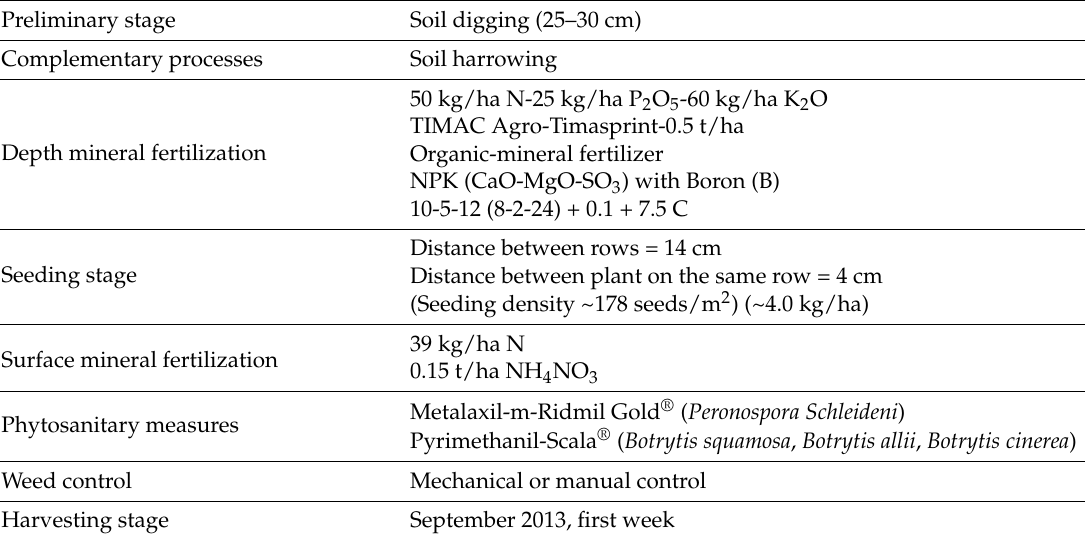
Table 5. Cultivation characteristics and modalities of the onion samples with both irrigation